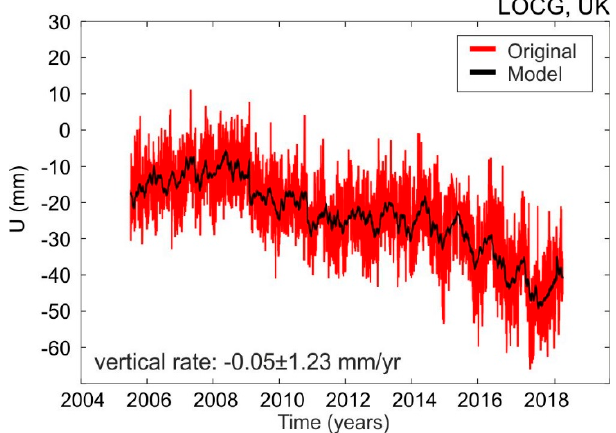
Figure 3. The GPS vertical position time series (in mm) for the LOCG station (Lochgilphead, UK) along with the time series model plotted, respectively, in red and black. The 4th polynomial degree is employed to model the non-linearity within the series. The LOCG station is estimated to subside by 0.05 ± 1.23 mm / yr. The large uncertainty of this vertical rate is caused by the significant non-linearity that the time series is characterized by. Due to its uncertainty, the vertical rate has been found as insignificant and removed from the GPS–GIA comparison, see text for details.